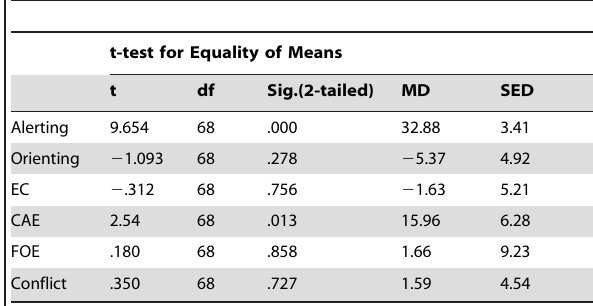
Table 5. Independent-samples t-test based on alerting level groups.